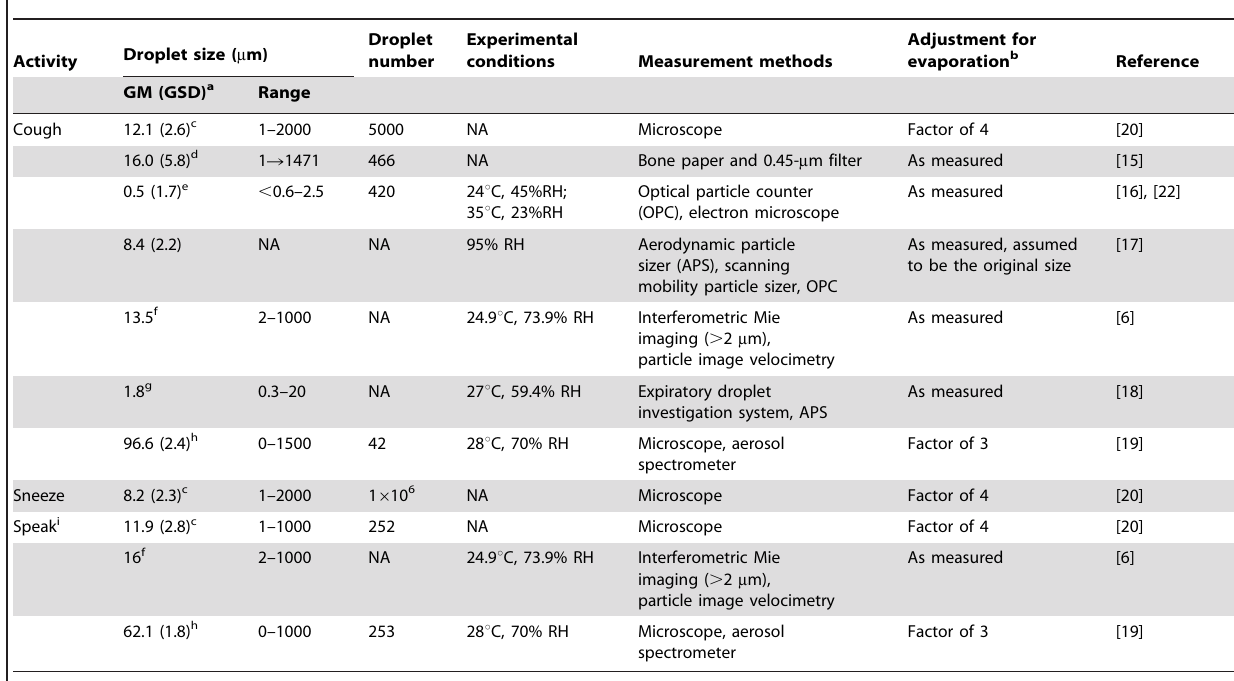
Table 1. Prior studies of respiratory droplet size